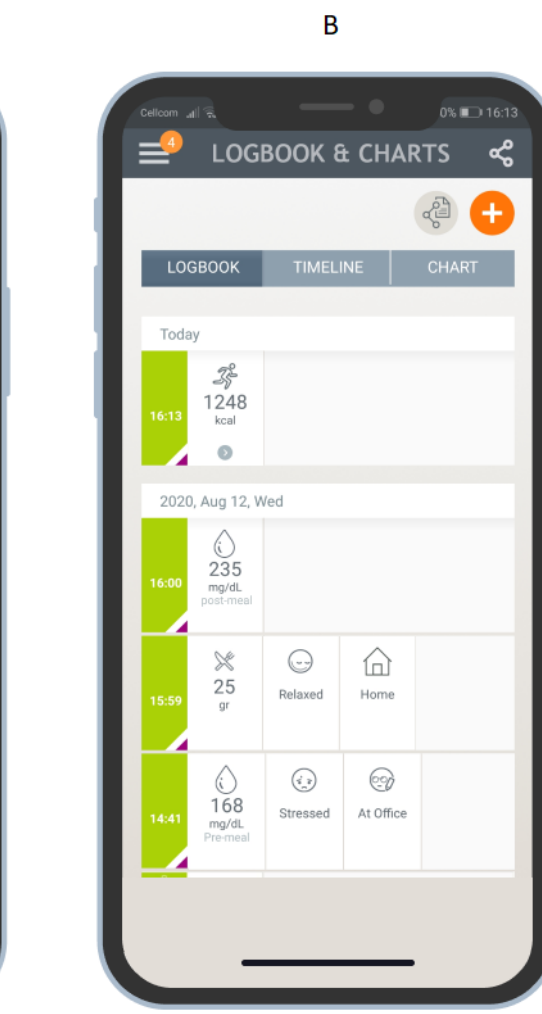
Figure 1. Dario mobile app platform. (A) Data entry screen allows tagging measurement type, carbohydrate intake (grams), physical activity (kcal), and tags such as mood setting and location. (B) Logbook screen presenting measurements and tagging